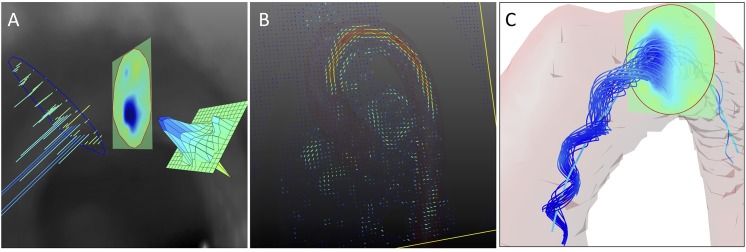
2D Visualization.(A) Visualization of vorticity values inside a ROI can be realized as a set of vectors, heatmap, or meshplot. Heatmap visualization lends itself to an intuitive vorticity analysis in its native three-dimensional surroundings, while vectors should be used to study the exact orientation of swirl. In this example, full vorticity vectors were limited to their through-plane component–correlating to swirl in the orientation of the ROI. (B) Two dimensional visualization of vorticity values as a color coded vector field, giving a first idea of areas with strong rotational flow. (C) A set of characteristic streamlines of the physiological vortex in the aortic arch, combined with an intersecting ROI displaying vorticity values and the automatically identified vortex core.